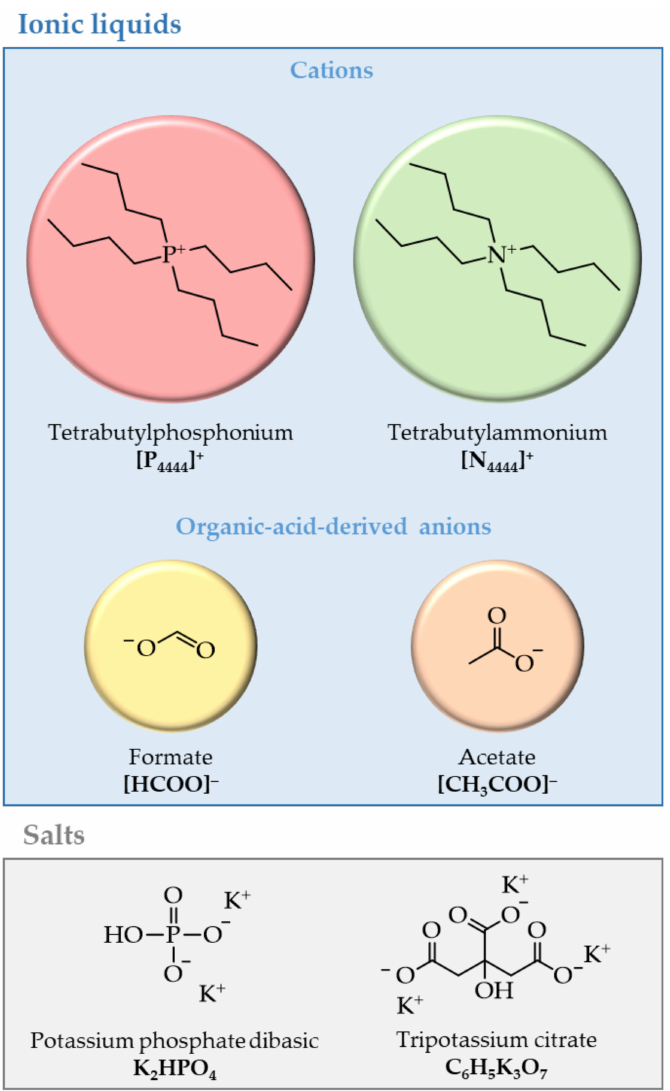
Figure 1. Chemical structures, names, and abbreviations of the ABSs constituents